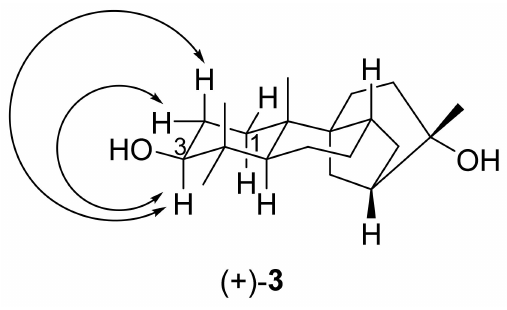
Figure 6. Vicinal coupling of H–C(3) in (+)-maritimol ( 3 ) [2].